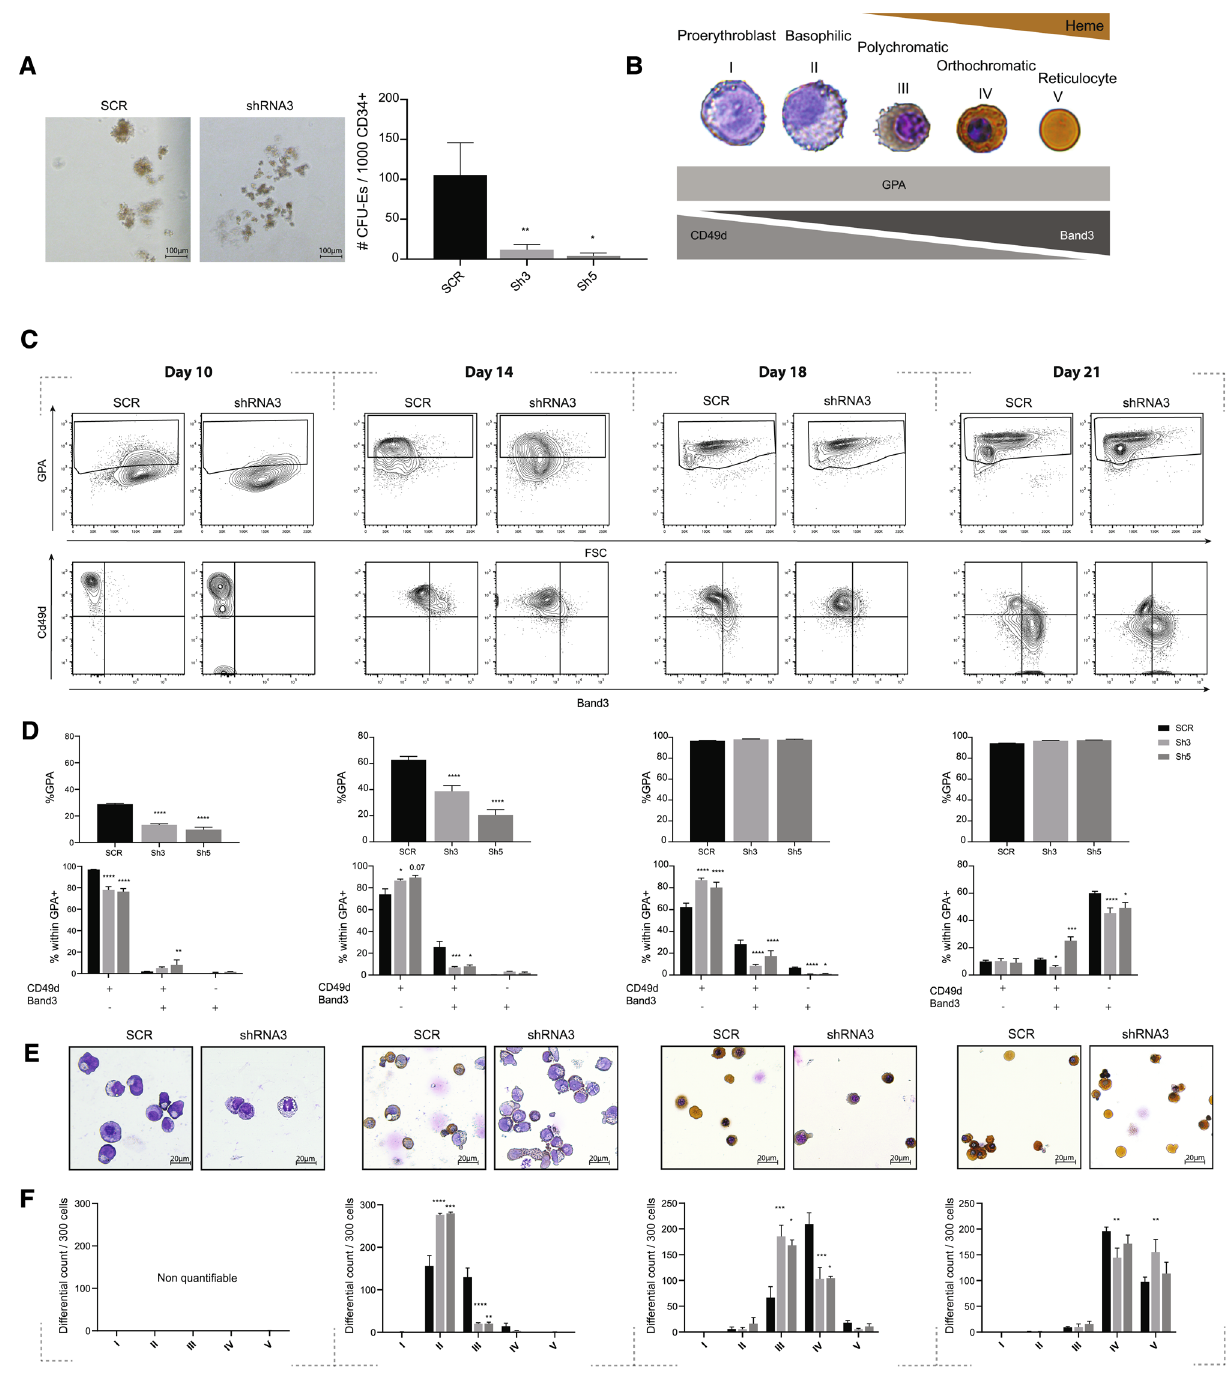
Figure 2. Decreased expression of PGC1β results in perturbed formation of early erythroid progenitors and delayed terminal differentiation in BM. ( A ) Representative pictures (left) and quantification (right) of CFU-E colonies at day 14 (n = SCR:4, Sh3:12, Sh5:6). ( B ) Schematic description of the cell morphology, cell surface markers and heme availability during terminal erythroid differentiation. The representative pictures are of erythroid progenitors from the erythroid culture, stained with DAB-Giemsa. ( C ) Representative plots and ( D ) quantification of flow cytometry analysis of GPA (top) and CD49d/Band3 within GPA + (bottom) on day 10, 14, 18 and 21 of erythroid in vitro differentiation (n = SCR:4, Sh3:12, Sh5:6). ( E ) Representative pictures at 40 × magnification and ( F ) quantification of progenitors from cytospins stained with DAB-Giemsa (n = 3–4). Quantification was not possible on day 10 as GPA + and GPA − progenitors cannot be differentiated. Data is presented as mean ± SEM (*P ≤ 0.05, **P ≤ 0.01, ***P ≤ 0.001, ****P ≤